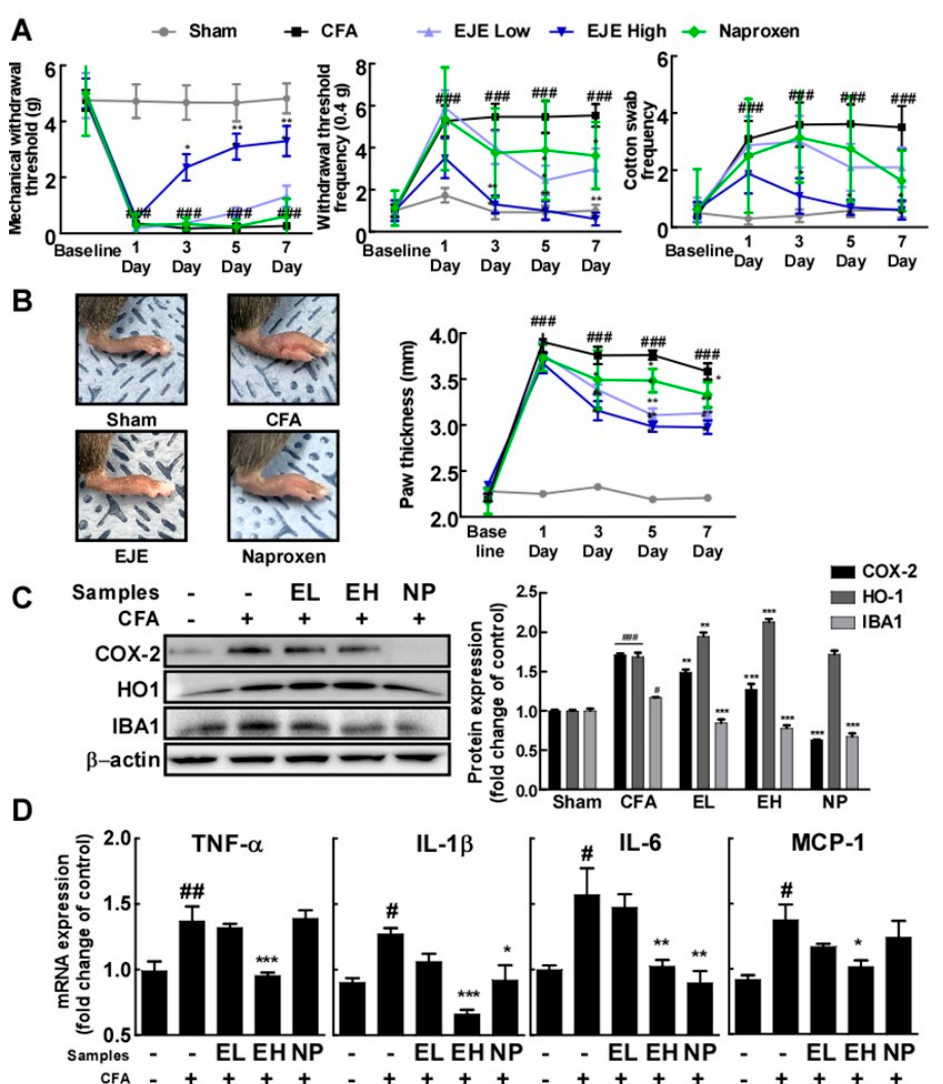
Figure 5. E ff ect of EJE on Complete Freund’s Adjuvant (CFA)-induced mechanical allodynia in mice and CFA-induced microglial activation and pro-inflammatory cytokine secretion in the spinal cord of 25 mice which were randomly allocated to 5 groups ( n = 5 mice per group, 5 groups in total): (i) control group (Sham), (ii) group treated with CFA (CFA), (iii) group treated with CFA and 50 mg / kg day EJE (EJE Low; EL), (iv) group treated with CFA and 200 mg / kg day EJE (EJE High; EH), (v) group treated with CFA and 10 mg / kg day naproxen (NP). The sham group was used as a control group in which the same volume of saline was injected into the right hind paw. Naproxen was used as a positive control. ( A ) EJE alleviated CFA-induced mechanical allodynia. ( B ) EJE alleviated CFA-induced foot swelling in mouse. ( C ) EJE reduced CFA-induced COX-2 and IBA-1 expression and increased HO-1 expression. Each expression level was detected by Western blot with antibodies. ( D ) EJE inhibited the secretion of pro-inflammatory cytokines induced by CFA in the spinal cord. The production of TNF- α , IL-1 β , IL-6 , and MCP-1 mRNA was analyzed by quantitative real-time RT-PCR, as described in Materials and Methods. Hash symbols (#, ## and ###) indicate a significant di ff erence ( p < 0.05, p < 0.01 and p < 0.001, respectively) between the control group and the group exposed to LPS alone; asterisks (*, ** and ***) indicate significant di ff erences ( p < 0.05, p < 0.01 and p < 0.001, respectively) between groups co-treated with LPS and EJE and the group exposed to LPS alone. In this and all the following Figures, data are presented as the mean ± SEM of three independent experiments.